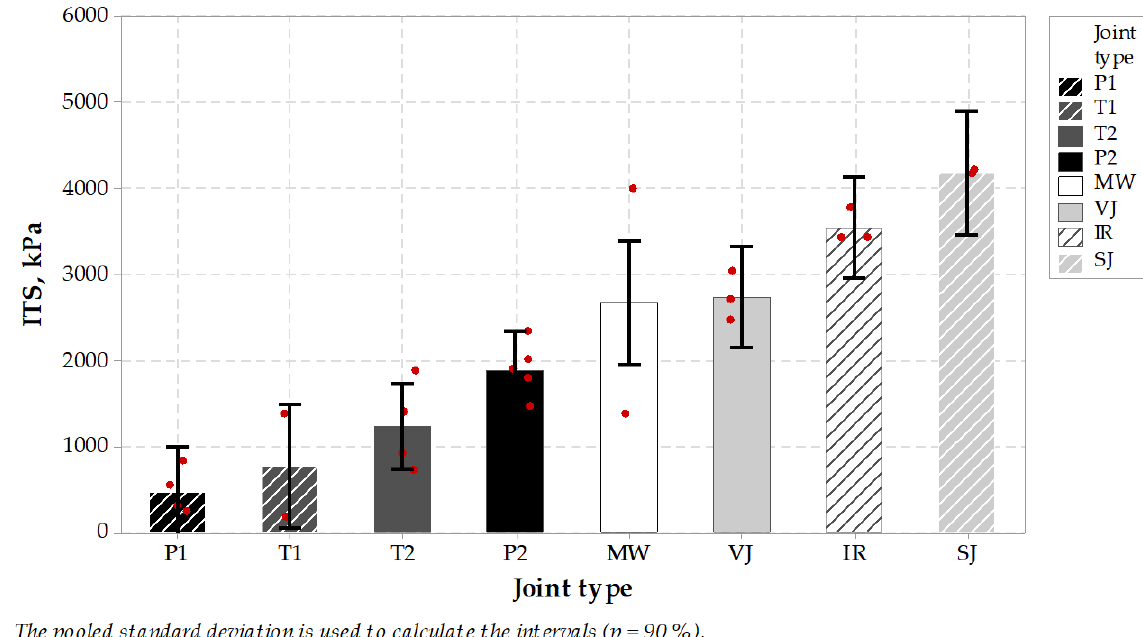
Figure 7. Indirect tension strength test results of specimens taken from longitudinal joints.